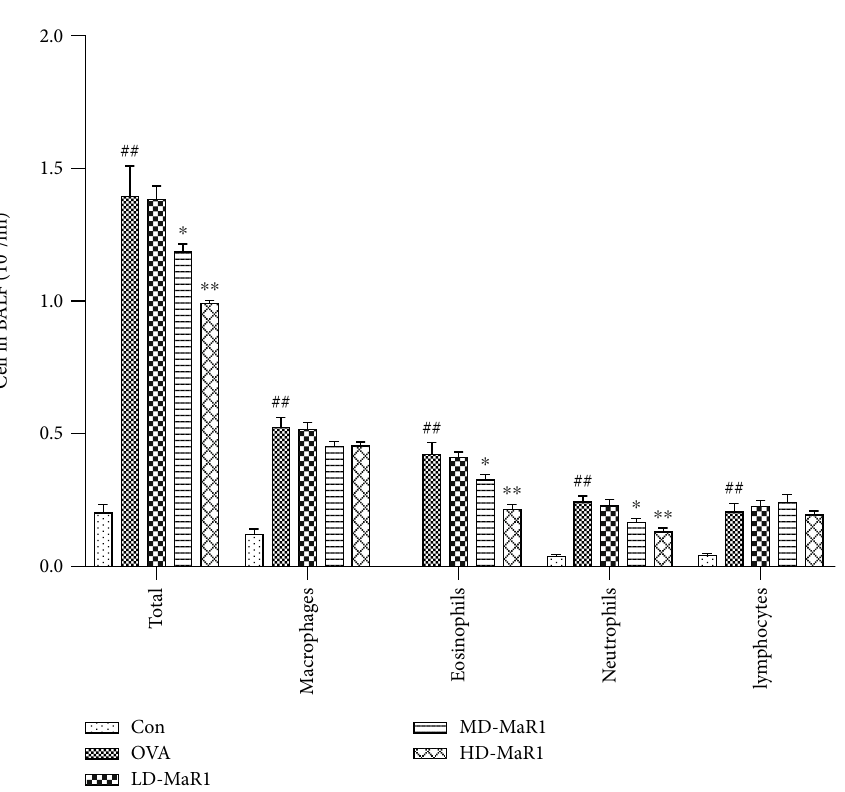
Figure 3: The experimental mice were subjected to alveolar lavage 24 hours after the last OVA aerosol challenge, and the BALF was taken for total cell counting and classi fi cation by Wright ’ s stain. MaR1 treatment suppressed OVA-induced in fl ammatory cell recruitment in a dose- dependent manner. Data expressed as mean ± SEM ( n = 6/group ). # P < 0 : 05 , ## P < 0 : 01 vs. the control group; ∗ P < 0 : 05 , ∗∗ P < 0 : 01 vs.